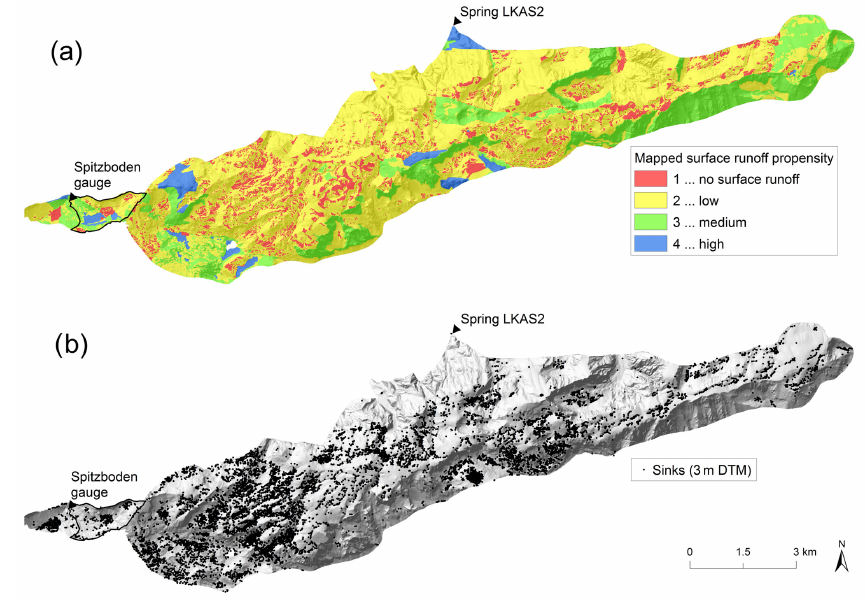
Figure 7. (a) Surface runoff propensity index in the whole study region (Hochschwab region). (b) Sink holes from the terrain model. Shading represents topography from the 1m terrain